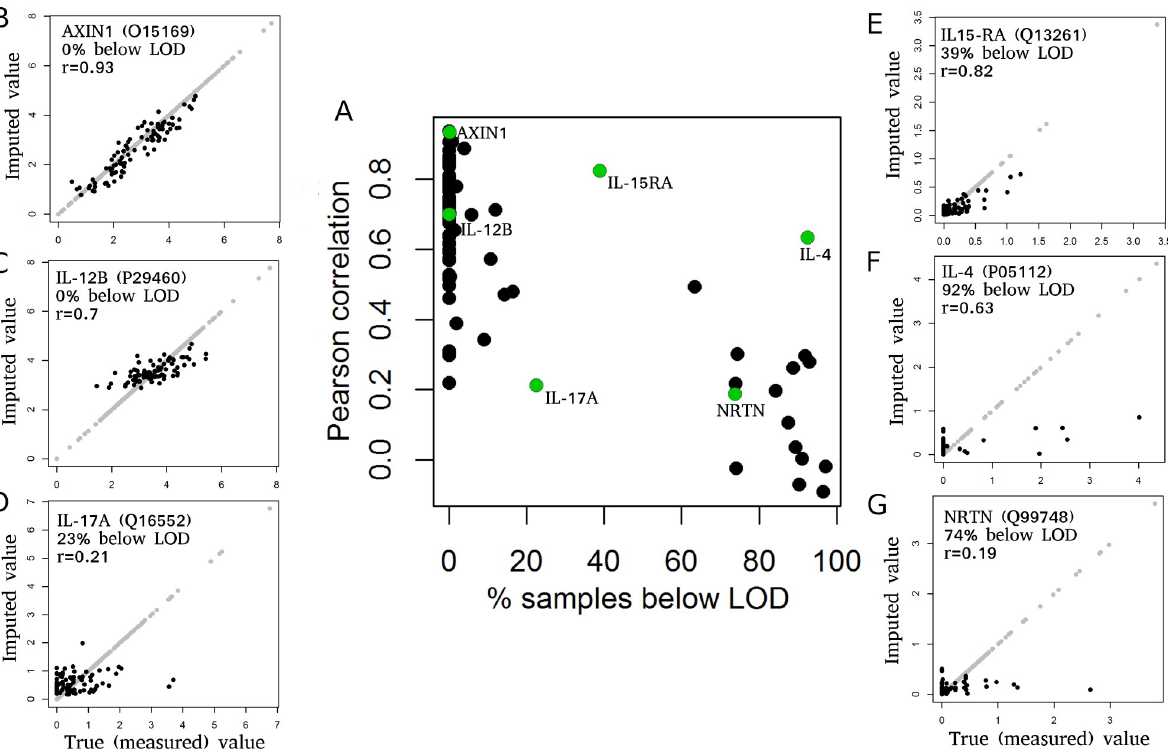
Fig 2. MissForest imputation vs. remeasurement. Pearson correlation and example scatterplots of imputed versus remeasured values for 91 proteins using missForest for imputation. (A) Pearson correlation between imputed and remeasured protein expression values (y-axis) versus fraction of samples below LOD (x-axis). Each dot represents one of 91 proteins. Proteins with many values below LOD tend to have reduced correlation values. (B-G) Scatterplots of remeasured (x-axis) versus imputed (y-axis) values for selected proteins. Protein names, fractions of samples below LOD and Pearson correlation value (r) are provided for each panel. Each dot represents one sample. Black dots represent the imputed and remeasured values. Light gray dots represent all values that did not have to be imputed and are visualized as reference. Scatterplots for all 91 proteins are provided in S5